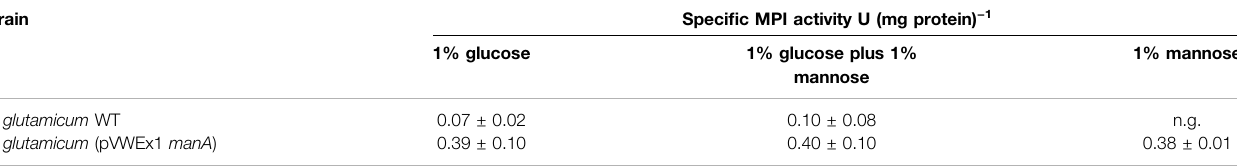
TABLE 2 | Speci fi c enzyme activities of mannose 6-phosphate isomerase (MPI) in cell extracts of C. glutamicum WT and C. glutamicum (pVWEx1 manA ) cells, harvested during mid-exponential phase with either glucose, glucose plus mannose, or mannose as carbon source(s).